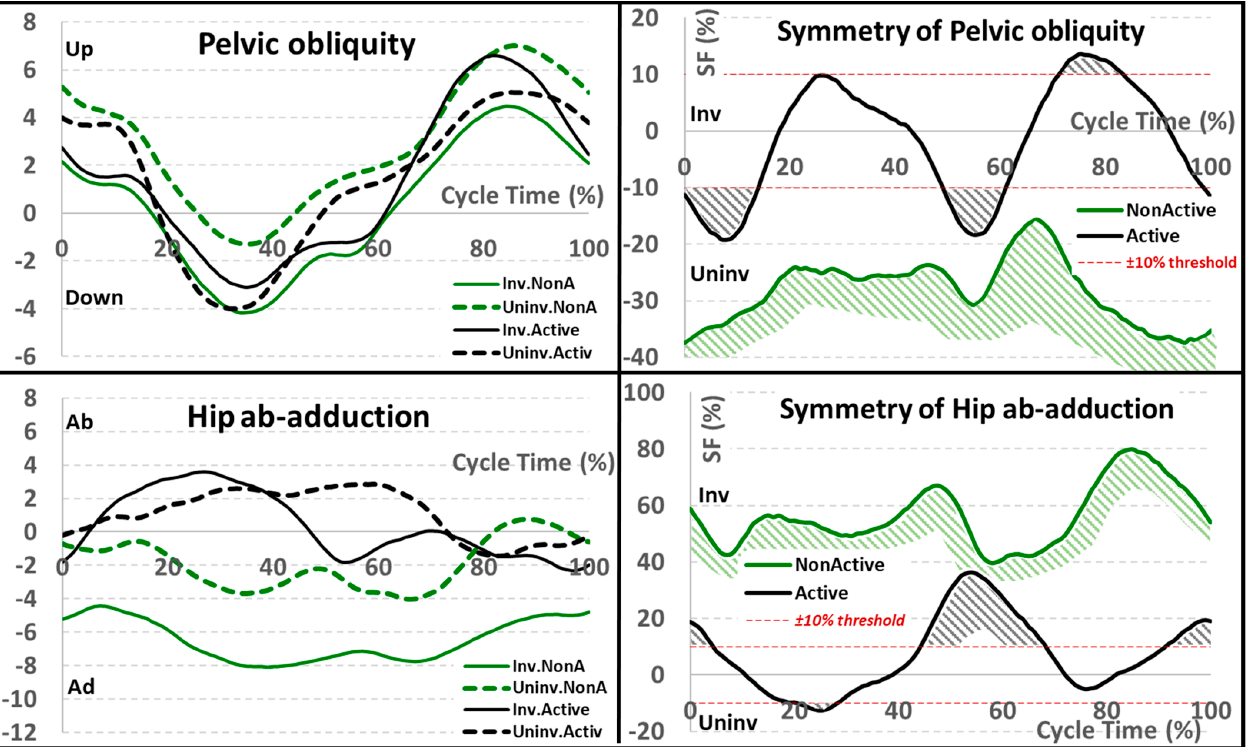
Figure 3. Frontal plane kinematics for pelvis and hip joints (in degrees) for involved/uninvolved limb and active/non-active groups ( on the left ); corresponding symmetry function (SF) for the active/non-active groups ( on the right ). The area exceeding the ± 10% threshold was highlighted to discriminate between symmetrical and asymmetrical patterns. All angles are in degrees and the SF in percentage.